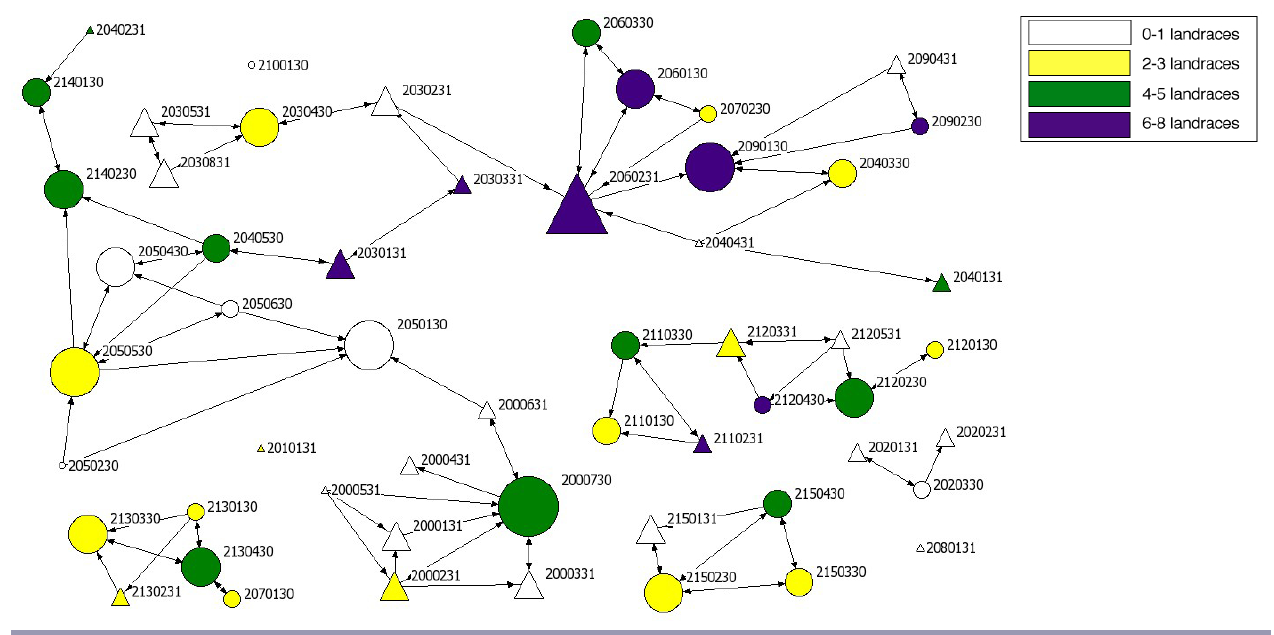
Fig. 3 . Local landrace conservation in relation to the number of seed exchanges. Note: Nodes (55 gardeners who where surveyed) are sized by the number of nominations that a person received on other people’s list (indegree), shaped by the sex of the node (triangle for men, circle for women), and colored to indicate the number of landraces kept by each gardener. The number next to the node corresponds to the identification number of the primary garden tender (the first three numbers for village of residency). Edges arrow represents the direction of the